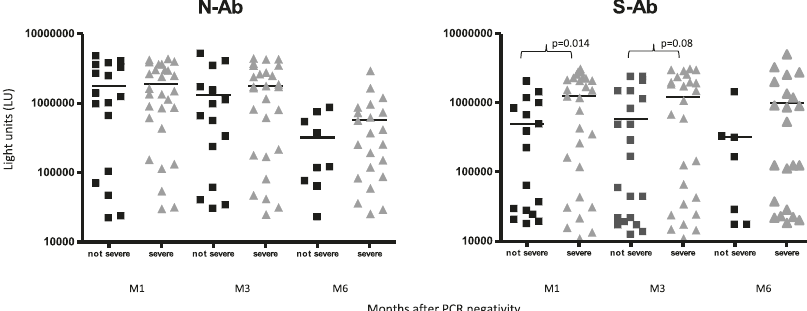
Fig. 3 Correlation of antibody levels against SARS-CoV-2 nucleocapsid and spike protein with patient severity. Antibody levels against SARS-CoV-2 nucleocapsid (N-Ab) and spike protein (S-Ab) were determined in the hematological cohort based on the clinical severity scale, severe vs non-severe, based on the criteria described in the material and methods. Each symbol represents an individual patient sample from a given timepoint. Antibody levels are plotted in light units on the y axis and the solid horizontal line represents the mean level for each group. Statistically signi fi cant differences in antibody levels among the sample group were determined by a Student ’ s t